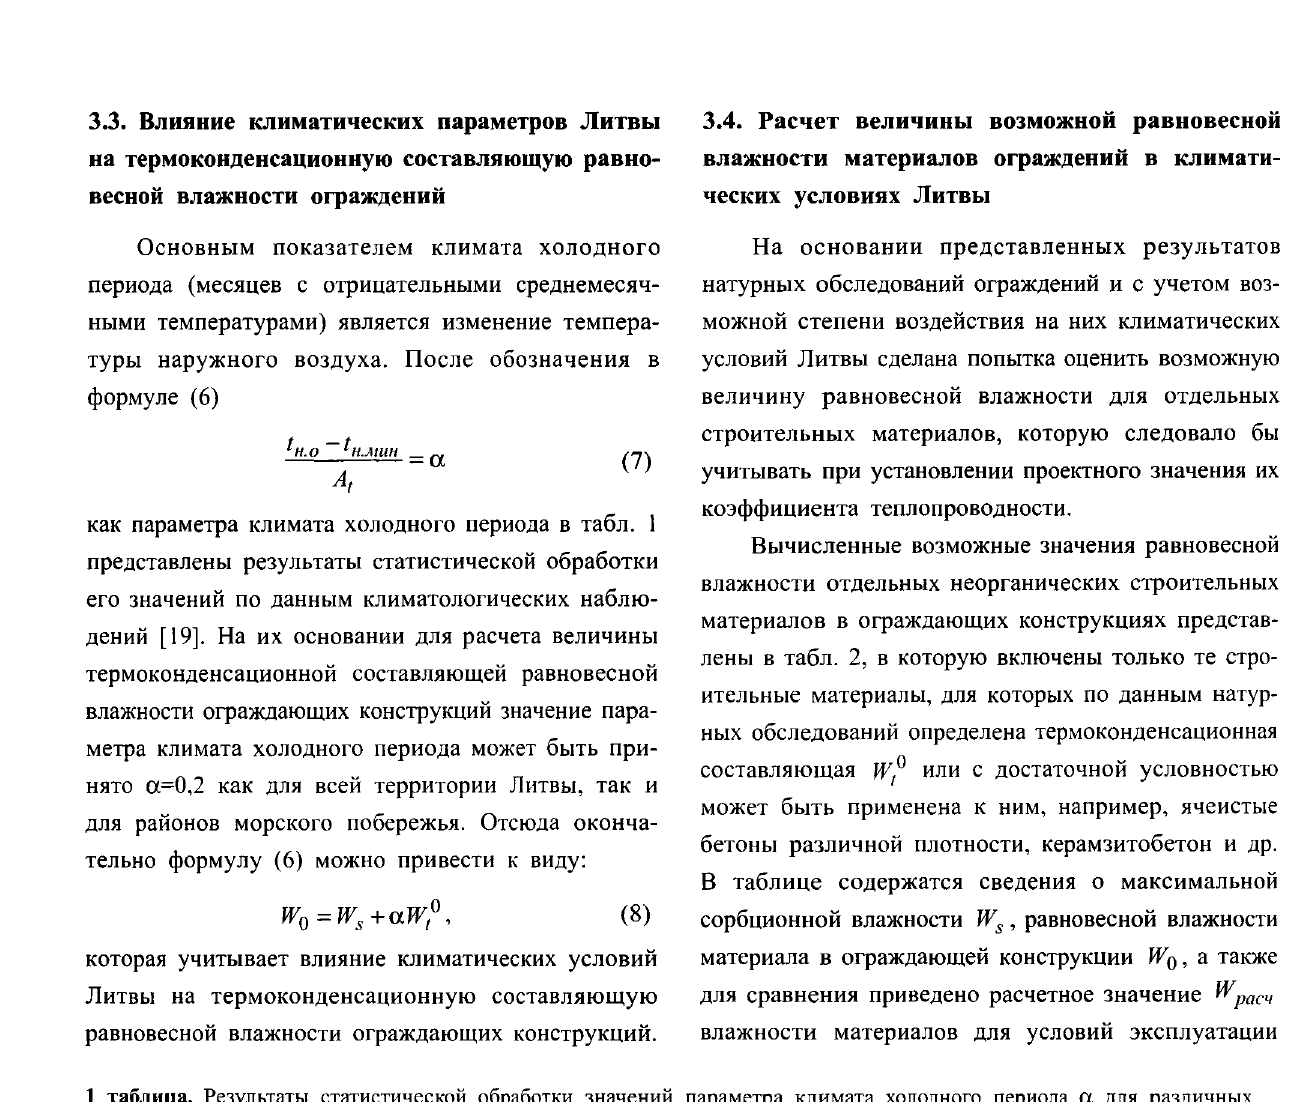
Table 1. The results of matematical-statistical treatment of cold season climatic parameter a values for Lithuanian regwns